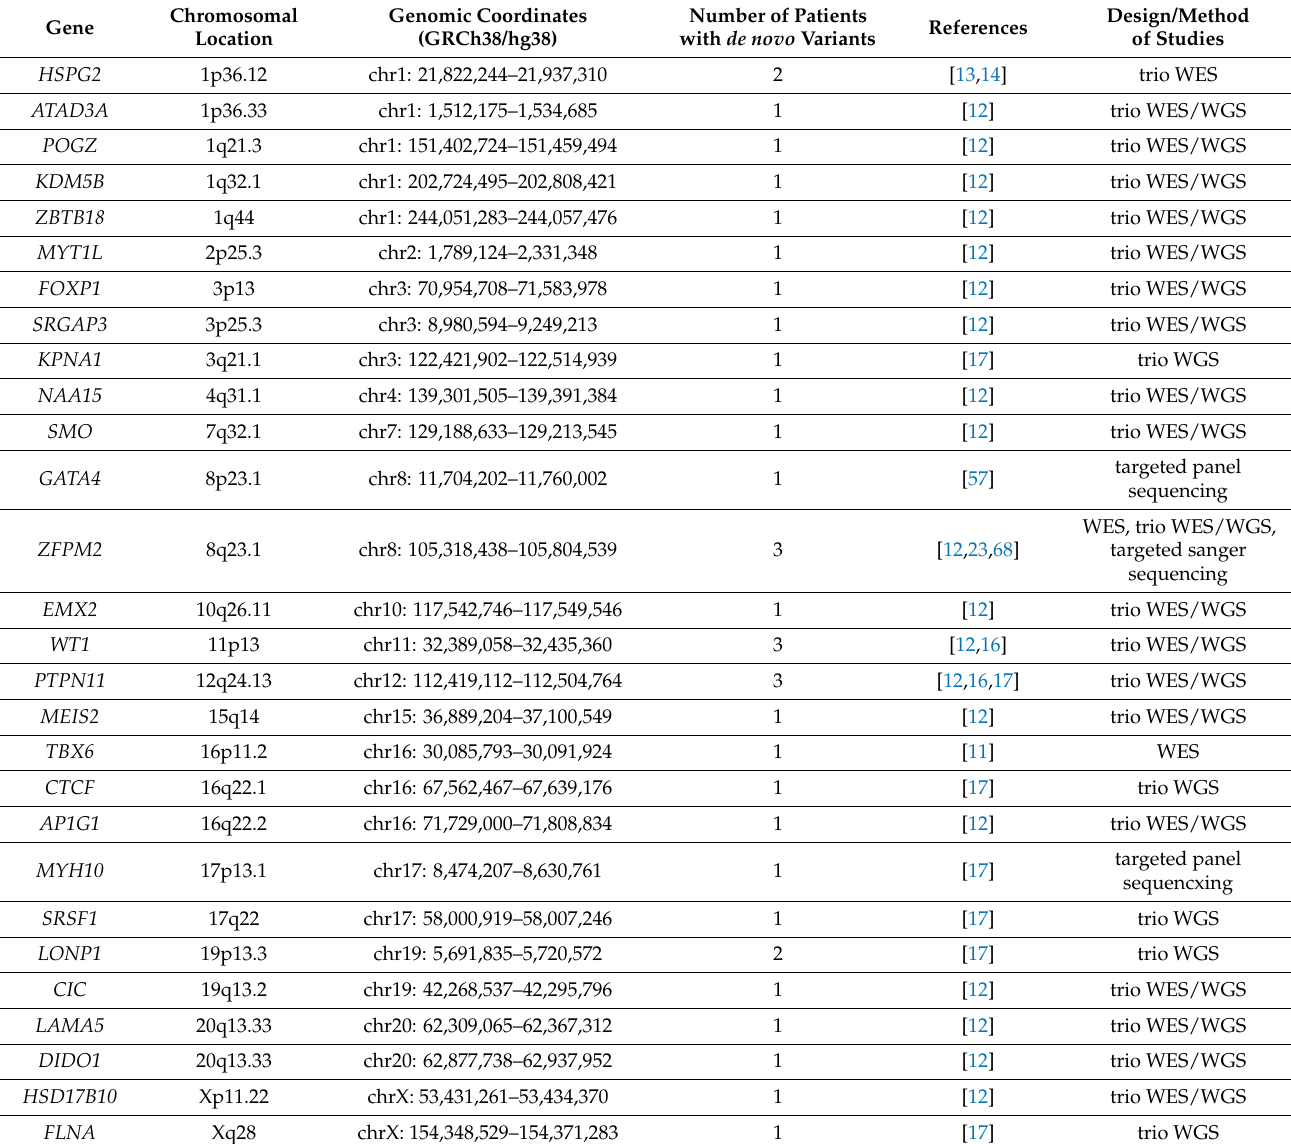
Table 3. Genes with de novo variants in isolated CDH